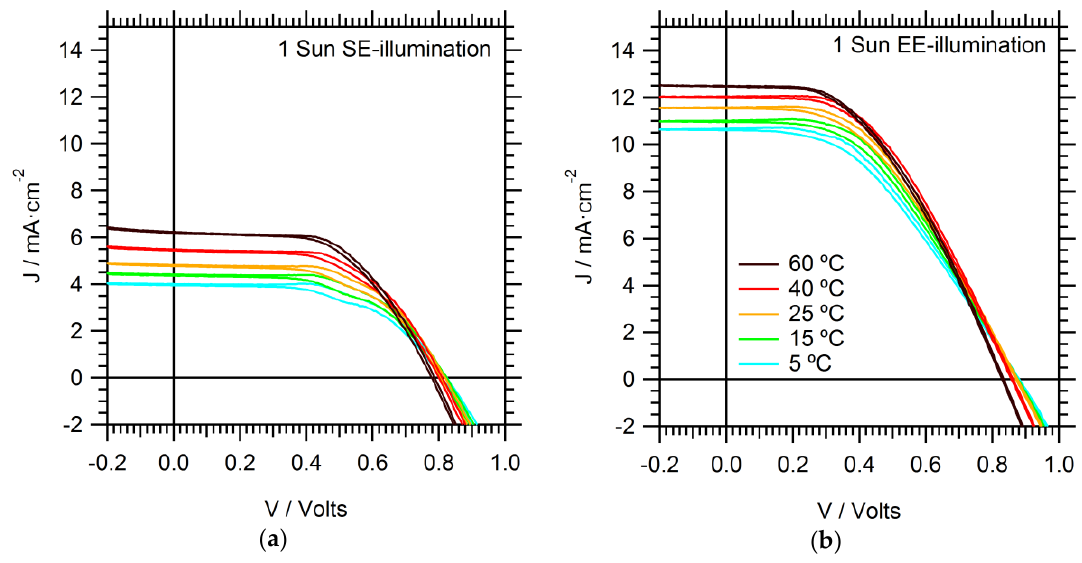
Figure 1. J – V curves of a DSSC with Co(bpy) 3 /TPAA/MPN electrolyte for ( a ) SE- and ( b ) EE- illumination. The film thickness is 6.5